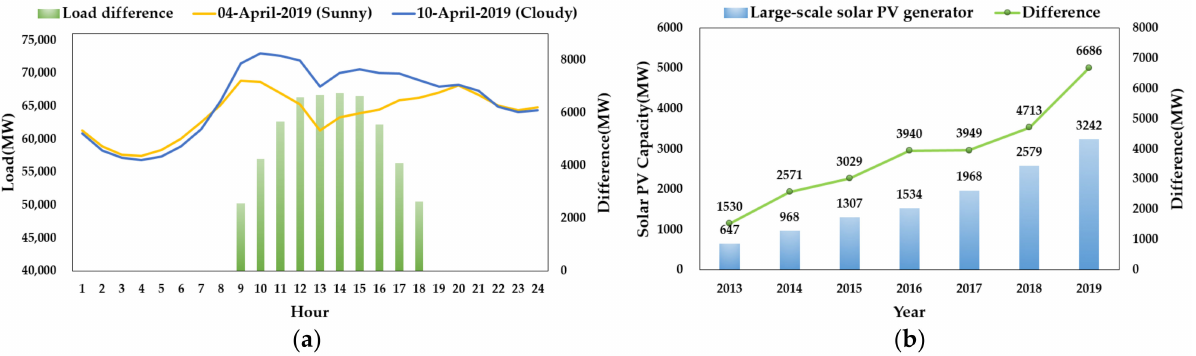
Figure 3. The volatility of electric load: ( a ) difference in electric load between a sunny day and a cloudy day in spring; ( b ) the capacity statistics of solar PV generator and the difference in electric load between a sunny day and a cloudy day by year.